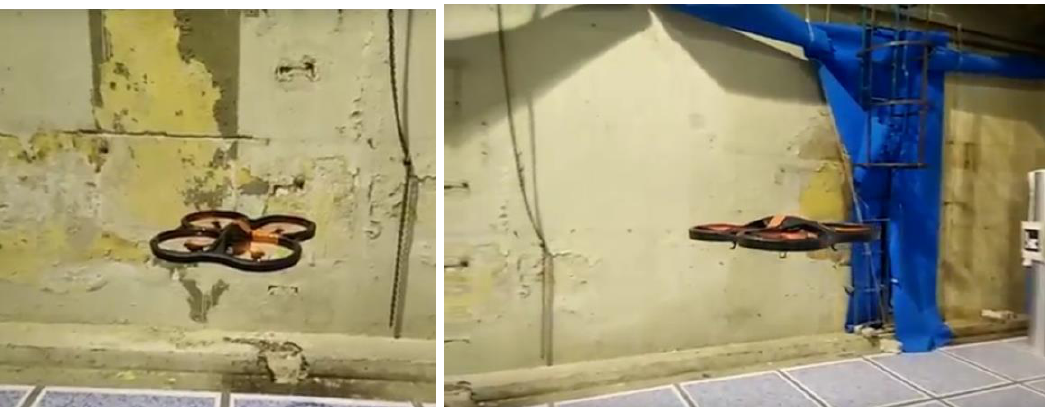
Figure 16. The aerial robot (AR Drone 2.0) during wall inspection. Sensors 2018 , 18 , x FOR PEER REVIEW